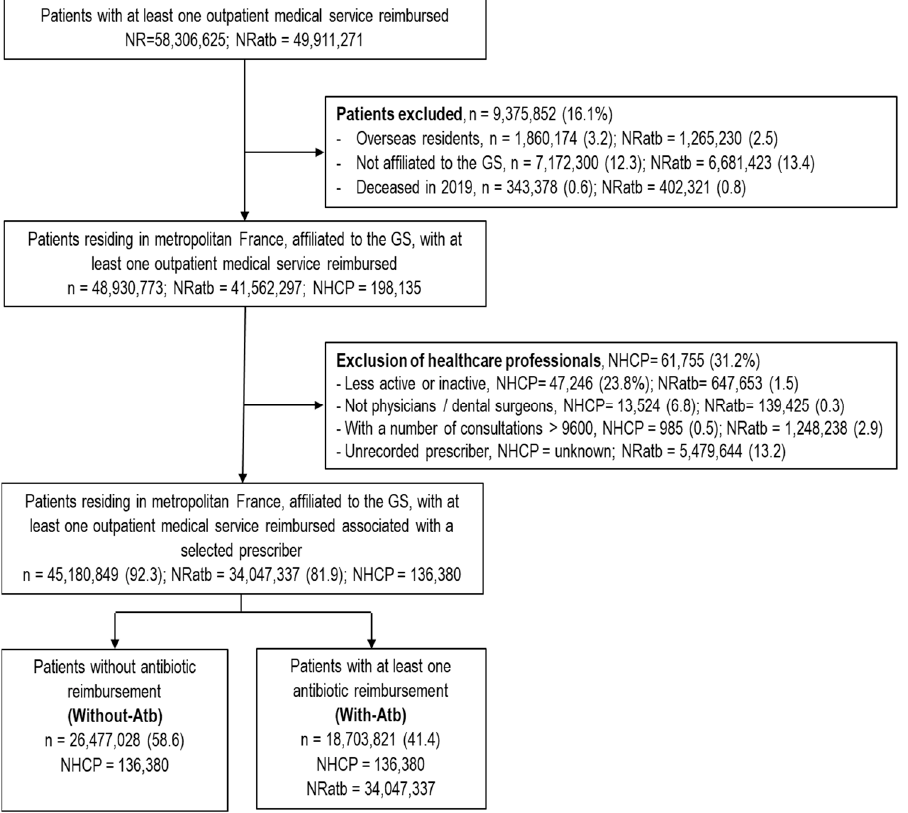
Figure 1. Flowchart of patient and prescriber selection from French health insurance databases (SNDS)—2019. n: Number of patients, NRatb: Number of reimbursements for antibiotics, NHCP: Number of healthcare professionals, HCP: Healthcare professional, GS: General scheme (main public health insurance scheme in France).